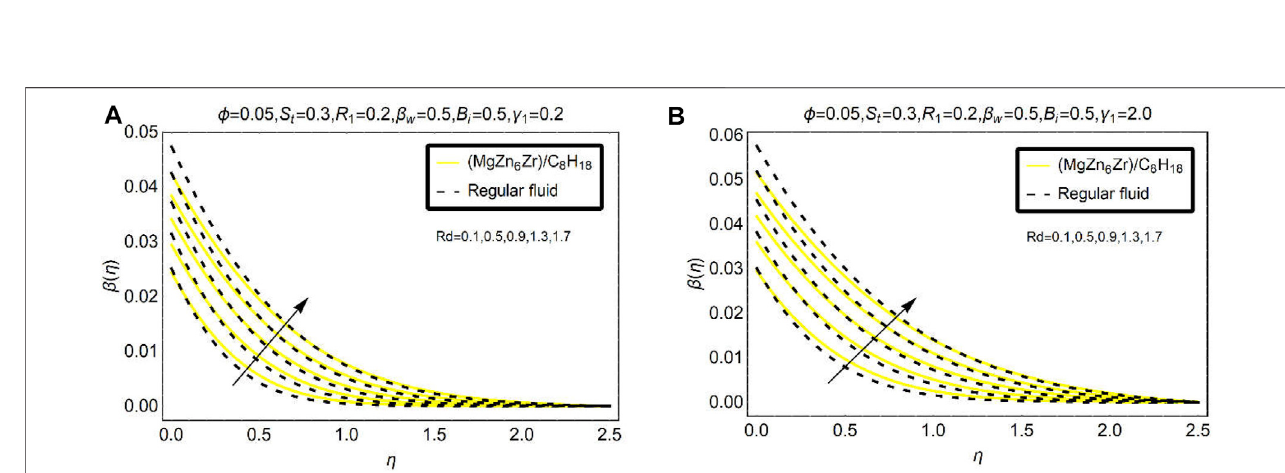
FIGURE 10 | Temperature via Rd (A) γ 1 (cid:2) 0 . 2 and (B) γ 1 (cid:2) 2 . 0.